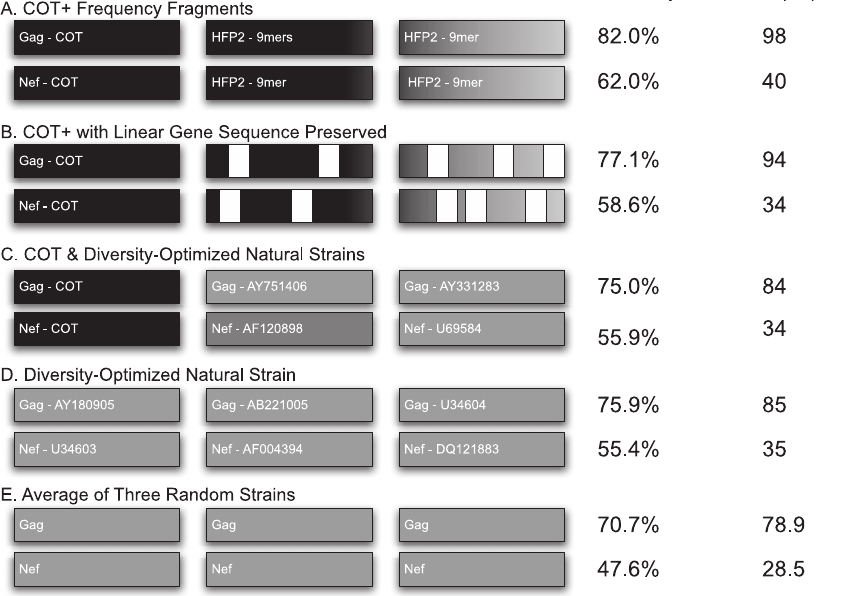
PLoS Computational Biology |